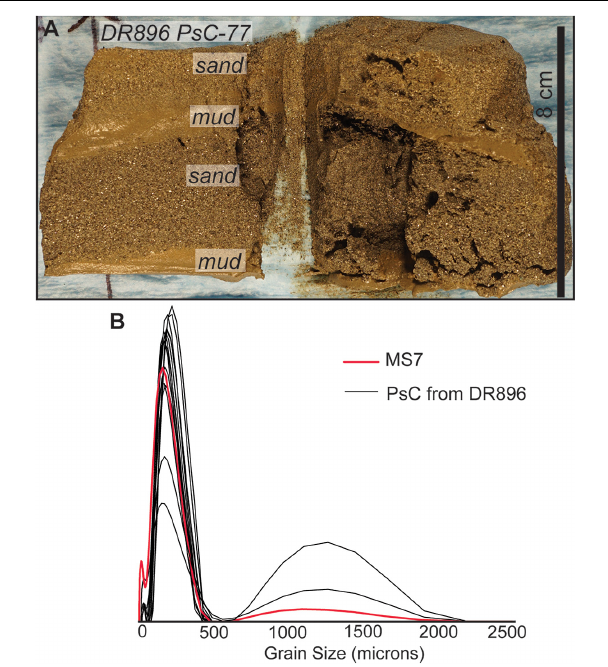
FIGURE 11 | Comparison of sediment from the September 1, 2016 sediment density flow event in MS7 trap and seabed samples. See Figure 1C for sample locations. (A) Photograph of an extruded and split pushcore acquired following the September 1, 2016 event. (B) Comparison of the coarsest grain-size distributions from MS7 sediment trap at 10 masf and nearby pushcores ( Supplementary Table S2